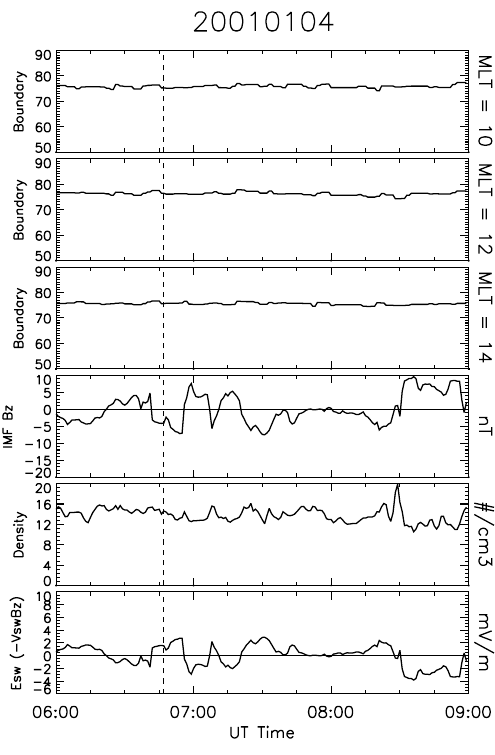
Fig. 4. A stack plot of the dayside boundaries for the isolated sub- storm on 4 January 2001. (a) The magnetic latitude of boundary at 10:00 MLT. (b) Magnetic latitude of the boundary at Noon. (c) Magnetic latitude of the boundary at 14:00 MLT. (d) . IMF B z (nT) (e) Solar wind proton density (number/cm 3 ) (f) The electric field (mV/m) of the solar wind calculated using the solar wind velocity and B z . The vertical line represent the onset of the expansion phase of the substorm as seen in ground based magnetometer data.